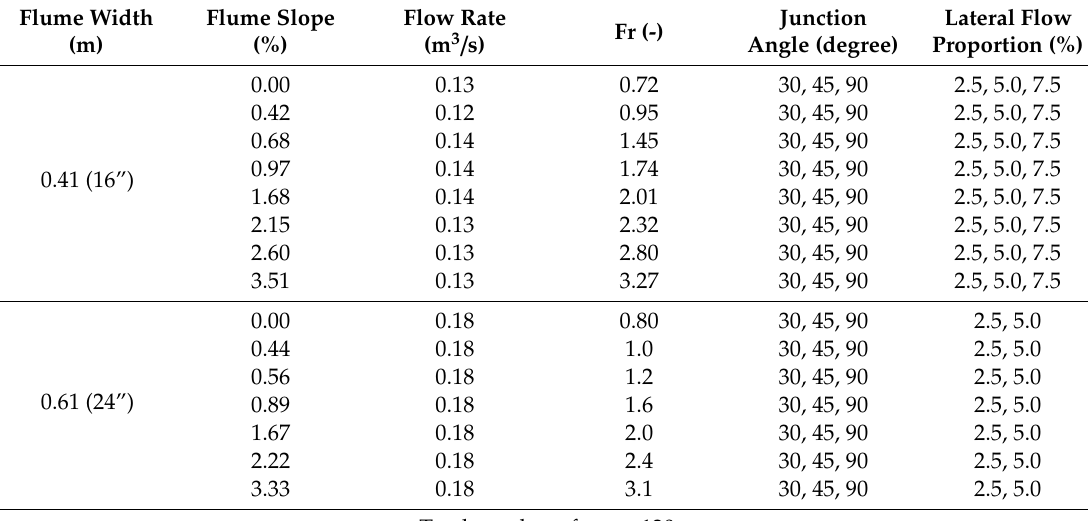
the bottom of a channel with a stainless-steel mounting bracket and a single screw into the bottom of the channel. This device uses a submerged ultrasonic sensor to measure the velocity, flow